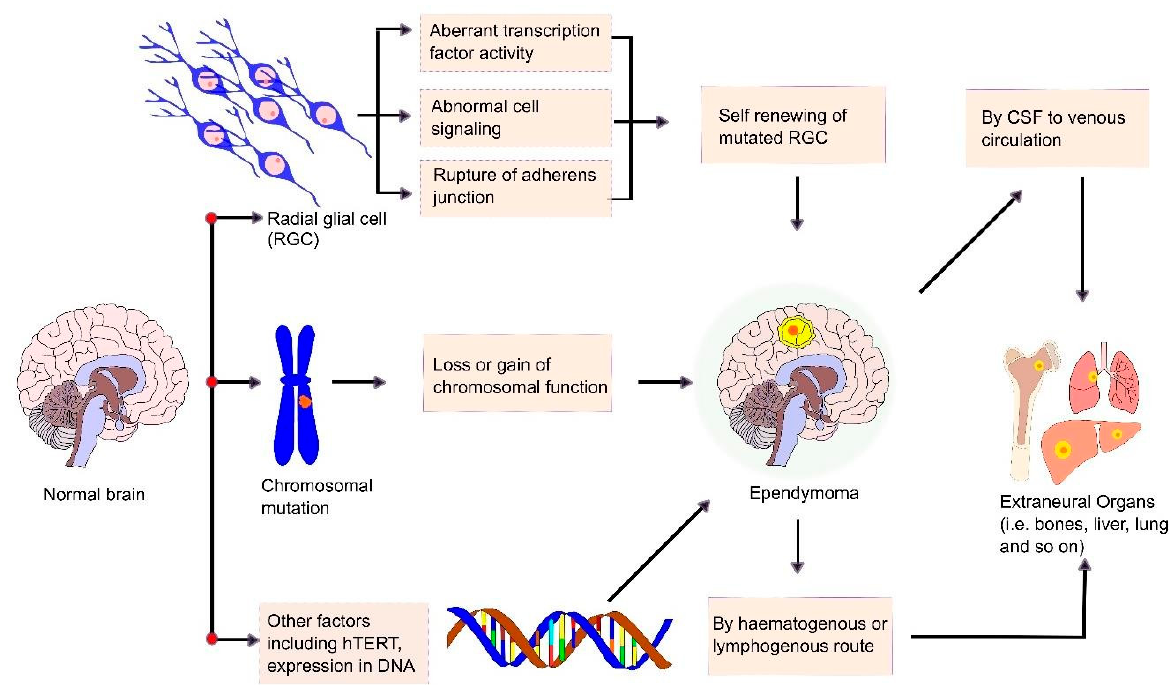
Figure 5. The possible mechanism of ependymomas and their metastasis. Ependymomas arise from the cranial ventricular system or spinal cord. Radial glial cells (RGCs) are thought to be the root cell of ependymomas. RGCs are multi-potent self-renewing progenitor cells in the brain that can proliferate into neurons and glial cells. The mutation of RGCs by aberrant transcription factor activity, adherens junction breakdown or abnormal cell signaling transforms them into a cancer stem cell. Chromosomal abnormalities also play a remarkable role in ependymal tumor formation. When tumor cells separate from their primary tumor, they metastasize to extraneural organs (e.g., skull, lungs, liver, bone, and lymph nodes) via several routes including haematogenous or lymphogenous routes.